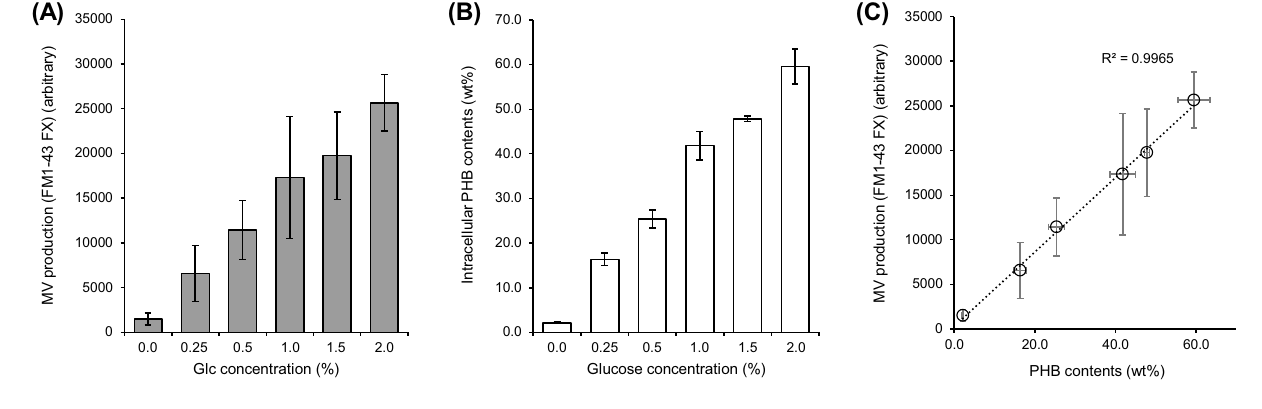
Figure 5. Relationship between MV production and intracellular PHB contents. ( A ) PHB production and ( B ) MV production of BW/PHB (+) under five different glucose concentrations (0–2.0%) for 48 h cultivation. ( C ) The relationship between the PHB production level and MV production level. The MV production clearly increased with increasing intracellular PHB production. The data are shown as the mean ± standard deviation from three independent experiments.